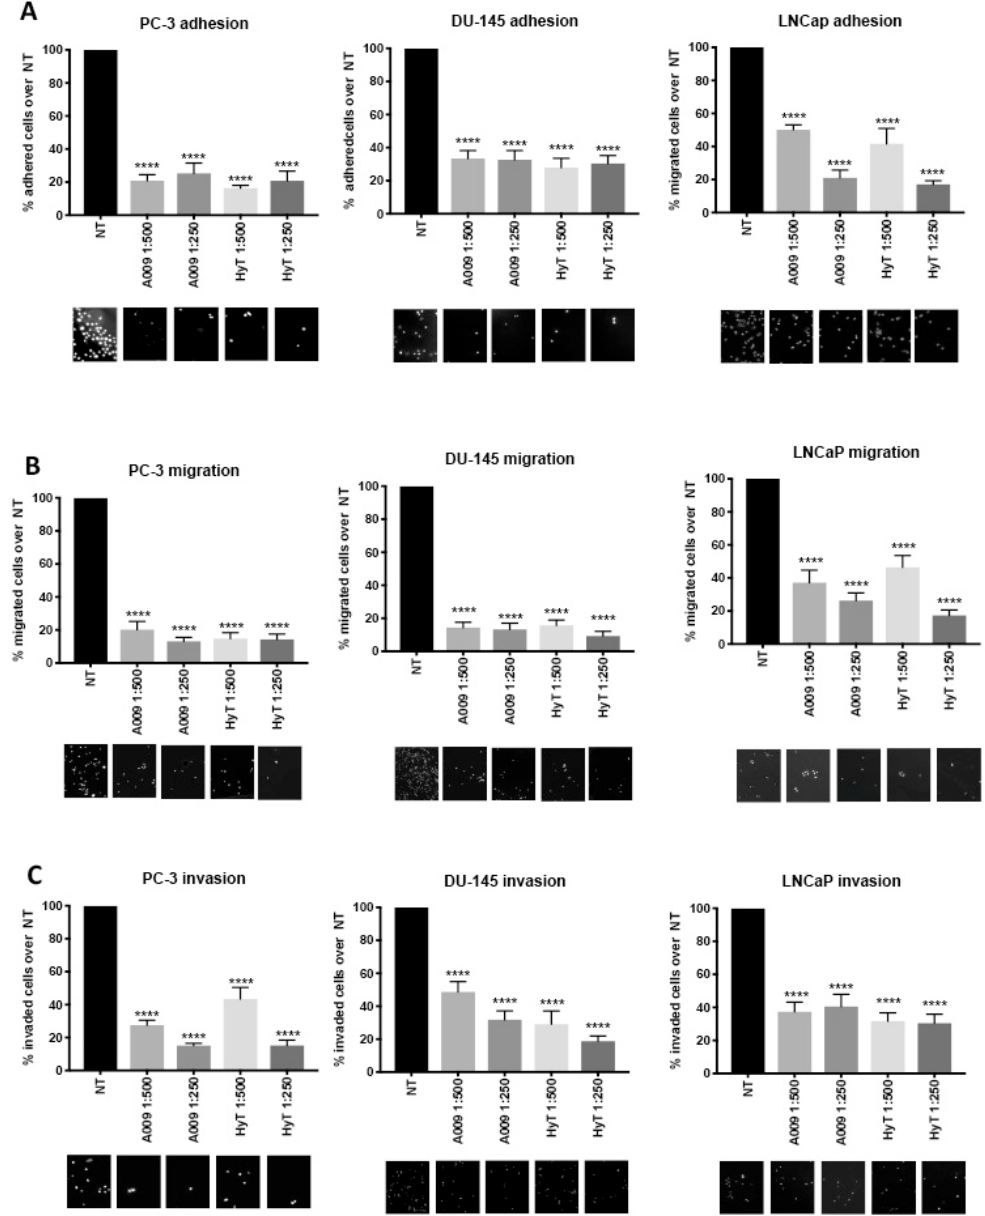
Figure 3. Effects of A009 on DU-145 and LNCaP human prostate cancer cell adhesion, migration, and invasion. PC-3, DU-145, and LNCaP were pre-treated for 24 h with A009 L4 or HyT, and their ability to prevent cell adhesion on fibronectin ( A ) migration on fibronectin ( B ) and invasion towards matrigel ( C ) was analyzed using Boyden chambers. Both A009 (dilution 1:500 or 1:500) and HyT were able to significantly inhibit cell adhesion, migration, and invasion in the three prostate cancer (PCa) cell lines. Representative images show adherent, migrated, and invading DU-145 and LNCaP cells at magnification 10×. Results are showed as mean ± SEM, ANOVA, **** p < 0.001.